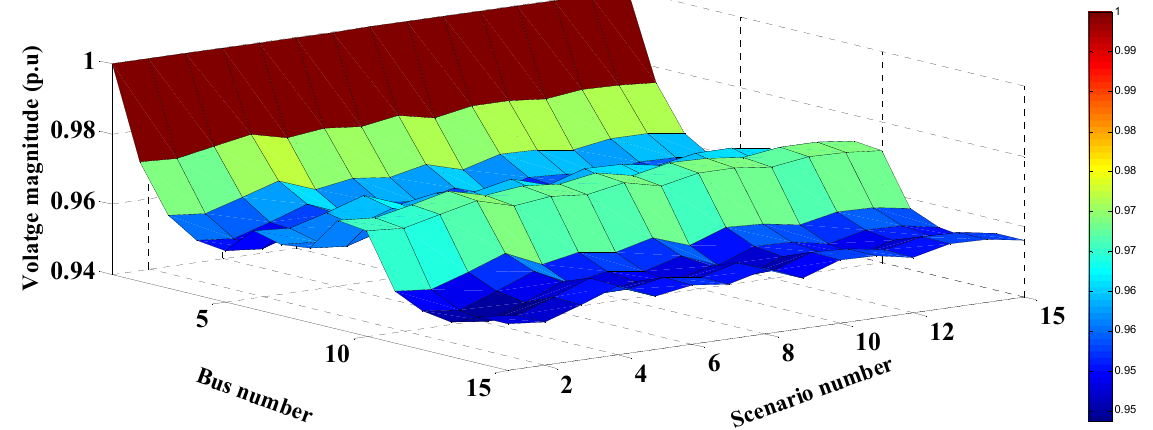
Figure 24. Bus voltage magnitudes of the 15-bus system without RERs.